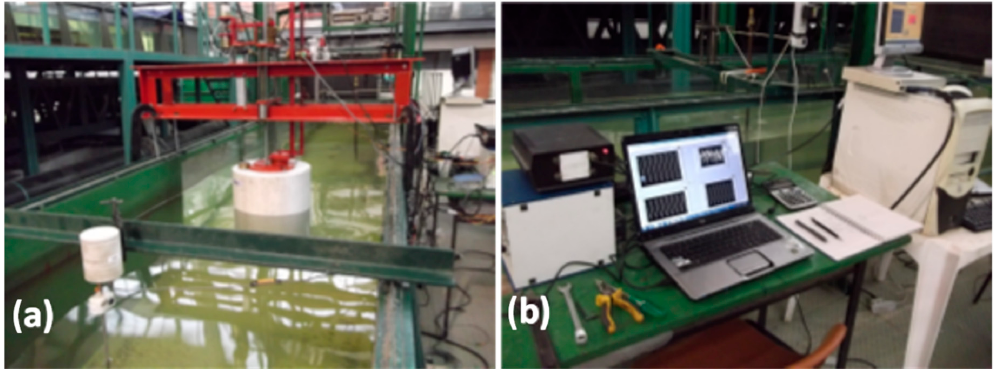
Figure 21. Schematic view of the power take-off (PTO) system.